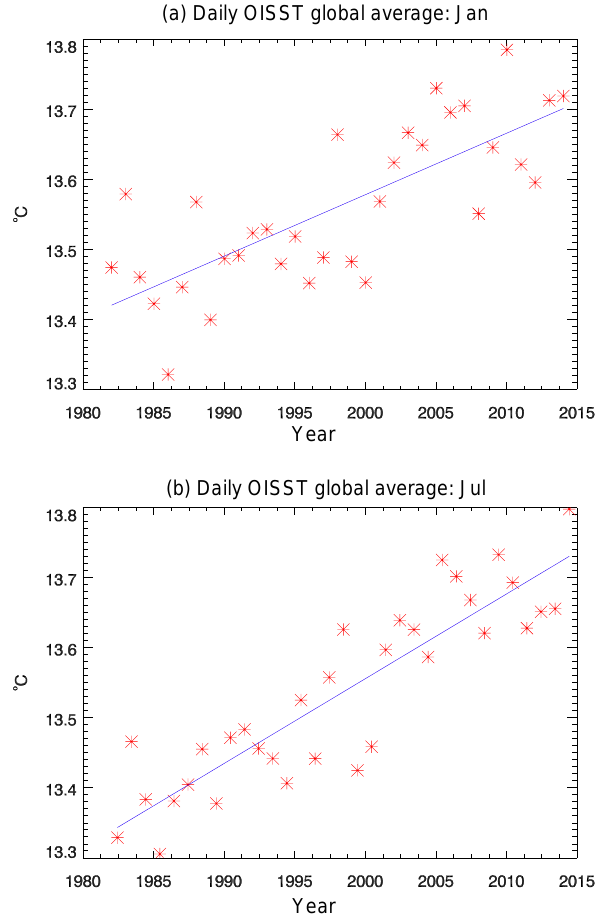
Figure 3. Global OISST trends (1982–2014) using (a) January monthly means only and (b) July monthly means